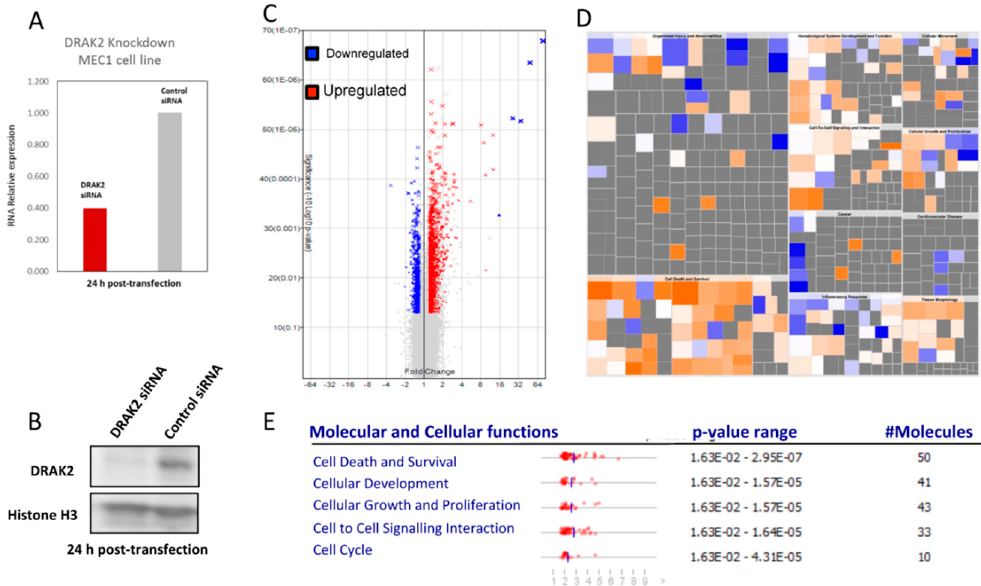
Figure 5. Microarray analysis reveals that MEC1 cells produce a differential gene expression signature upon DRAK2 siRNA knockdown. ( A ) DRAK2 siRNA knockdown in MEC1 cells strongly reduces DRAK2 RNA and ( B ) protein levels. ( C ) Volcano plot in which gene expression is calculated as a linear fold change relative to MEC1 cells treated with siRNA control. p -value is calculated by one-way between-subject ANOVA for unpaired samples. Red data points represent genes expressed > 1.2-fold and blue data points represent genes expressed < 1.2-fold in MEC1-siRNA-DRAK2 versus MEC1-siRNA-control, where p < 0.05. ( D ). Ingenuity’s pathway analysis of DRAK2 mediated putative genes, and biological pathways are depicted using a color-coded heatmap. The color intensity of the squares in the heatmaps reflects the strength of the absolute z-score for predictions (orange = positive, blue = negative). The size of the squares reflects the z-score values. The top five molecular and cellular functions deregulated in MEC1 cells upon DRAK2 knockdown are given in the lower panel.